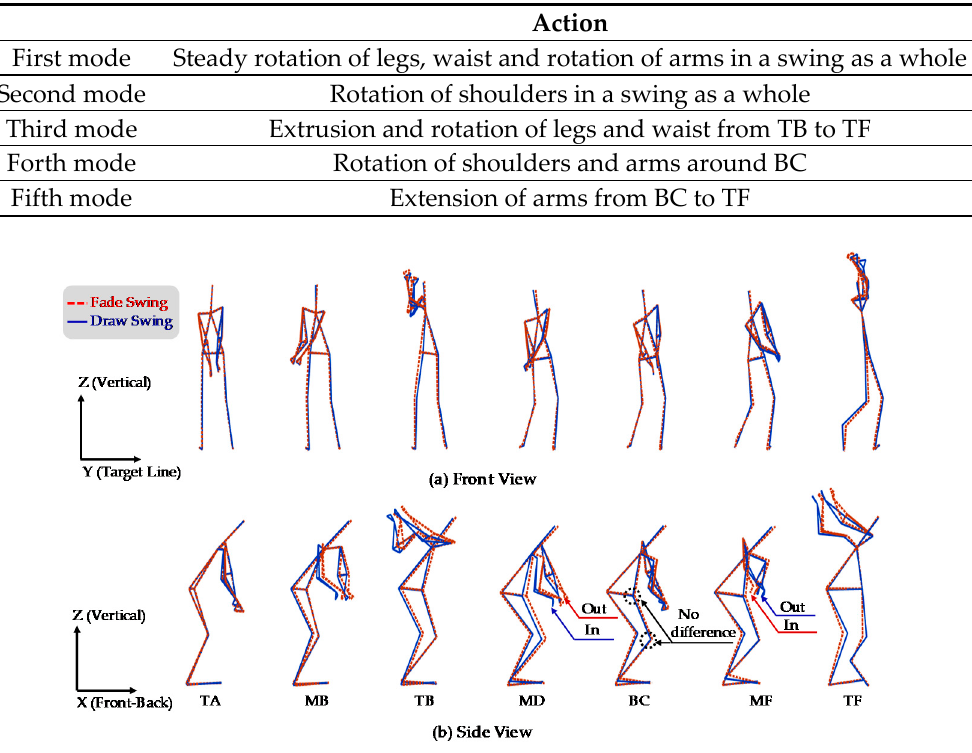
Figure 4. Stick pictures comparing sums of first to fifth mode swing: ( a ) front view ( b ) side view. Red pictures show a fade swing and blue pictures show a draw